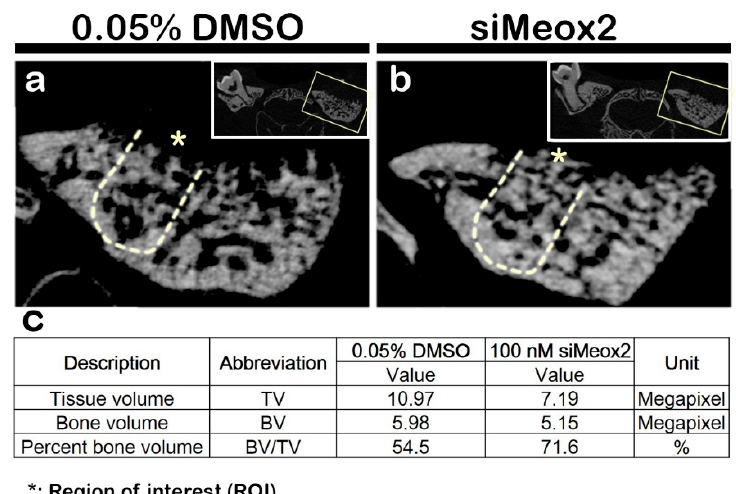
Figure 6. Micro-CT analysis of the tooth root socket and newly formed bone. After 2 weeks, the carrier control (DMSO) treated specimens show less volume of bone formed ( a ) compared with that in the knocking down of Meox2 ( b ). The solid boxes depict higher magnification views. The table of analysis determined using CTAn software ( c ).